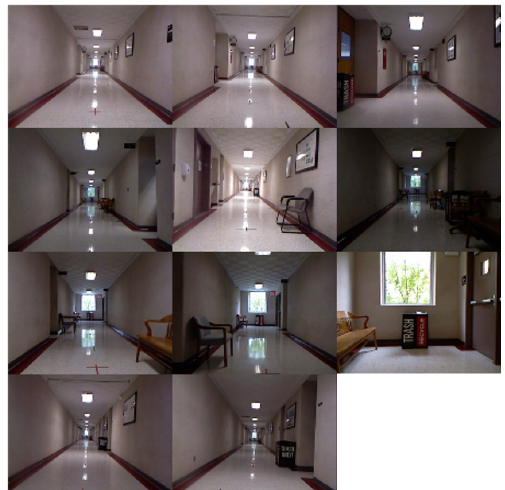
Figure 10. Query images took by Kinect V1 on 11 green test points. It is obvious that the Kinect RGB camera is sensitive to the change of illumination in the